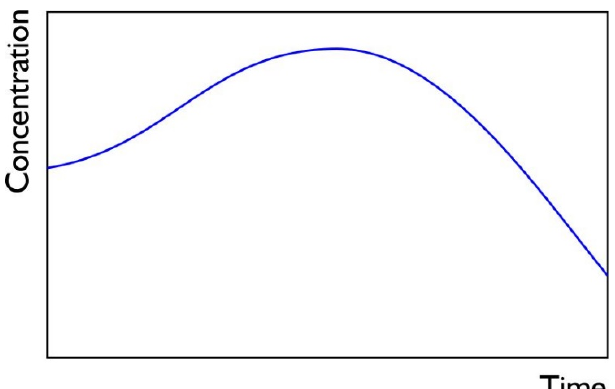
Figure 6. Typical theoretical profile of the concentration of bioactive compounds subjected to plasma processing showing the theoretical effect of overexposure to plasma.